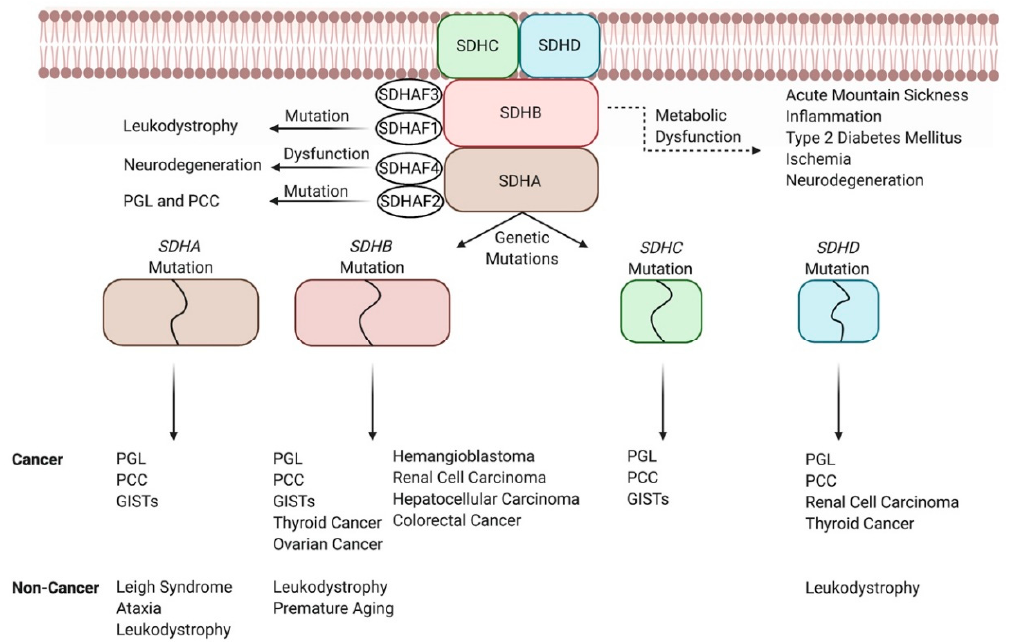
Figure 2. Genetic and metabolic dysfunction of the SDH complex and its link to diseases. For instance, SDHB mutations lead to the development of paraganglioma (PGL), pheochromocytoma (PCC), ovarian cancer, colorectal cancer, gastrointestinal tumors (GISTs), and other cancers. Similarly, SDHB mutations can cause non-cancer diseases such as leukodystrophy and premature aging. Another way that abnormal SDH activity causes the disease is through its metabolic dysfunction, as seen with decreased activities of SDHA and SDHB through epigenetic modification causing acute mountain sickness.